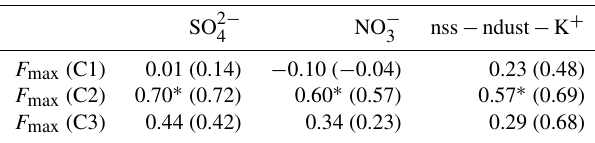
Table 4. Pearson’s correlation coefficients ( r ) of major ions and F max for fluorescent components when excluding the data from site 67; the results for the entire data set are shown in parentheses. Note that ∗ denotes p < 0 .